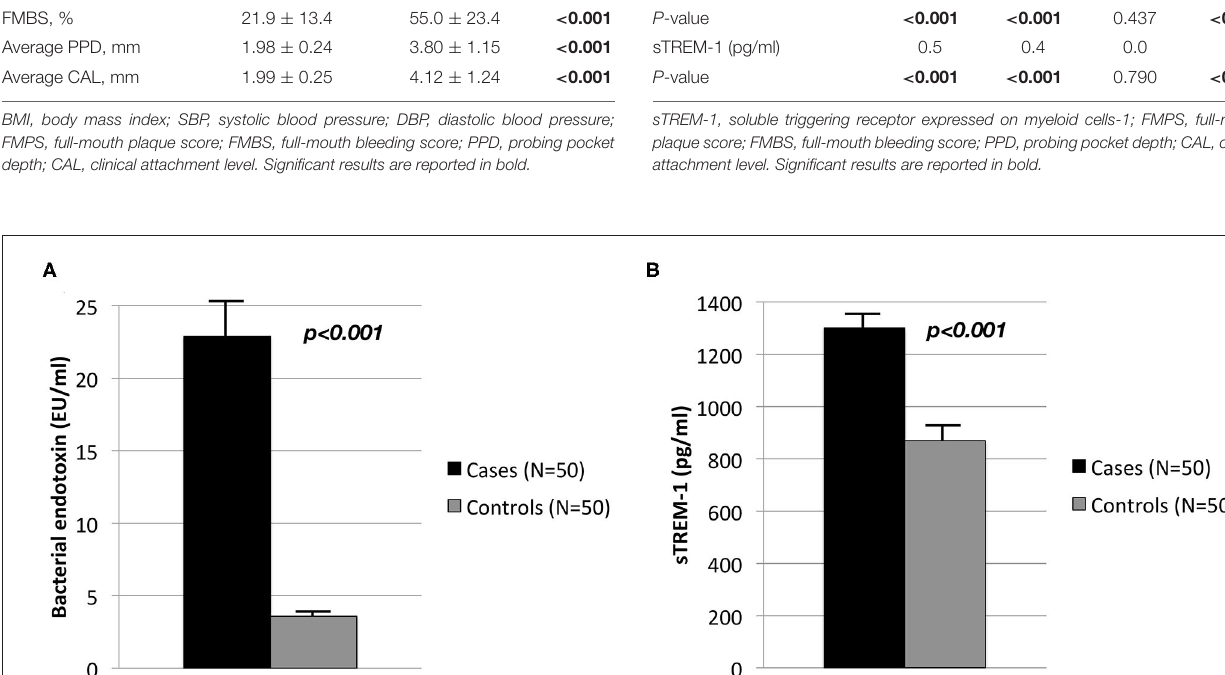
Frontiers in Oral Health |